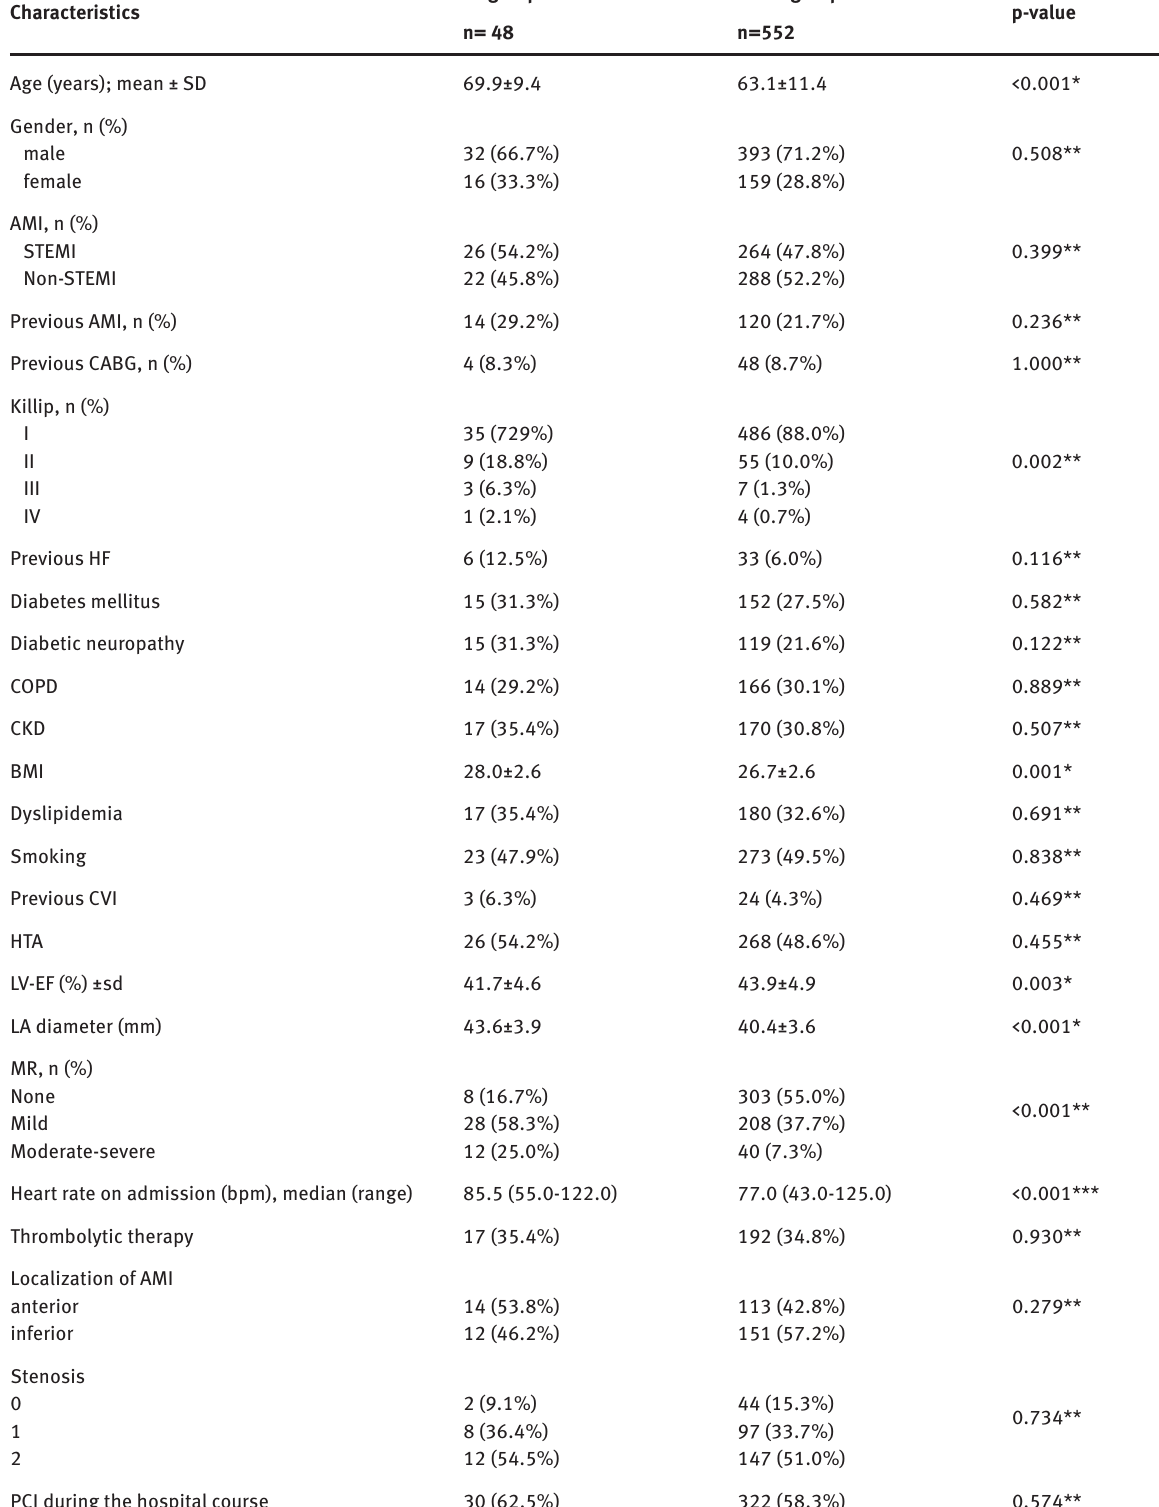
Table 1: Baseline characteristics in regards to the presence or absence of AF during the hospital period